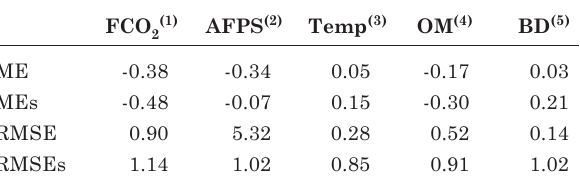
(1) Soil CO emission; (2) Air-filled pore space; (3) Soil temperature; 2 (4) Organic matter; (5) Soil bulk density; (6) Ordinary kriging; (7) Sequential Gaussian simulation.